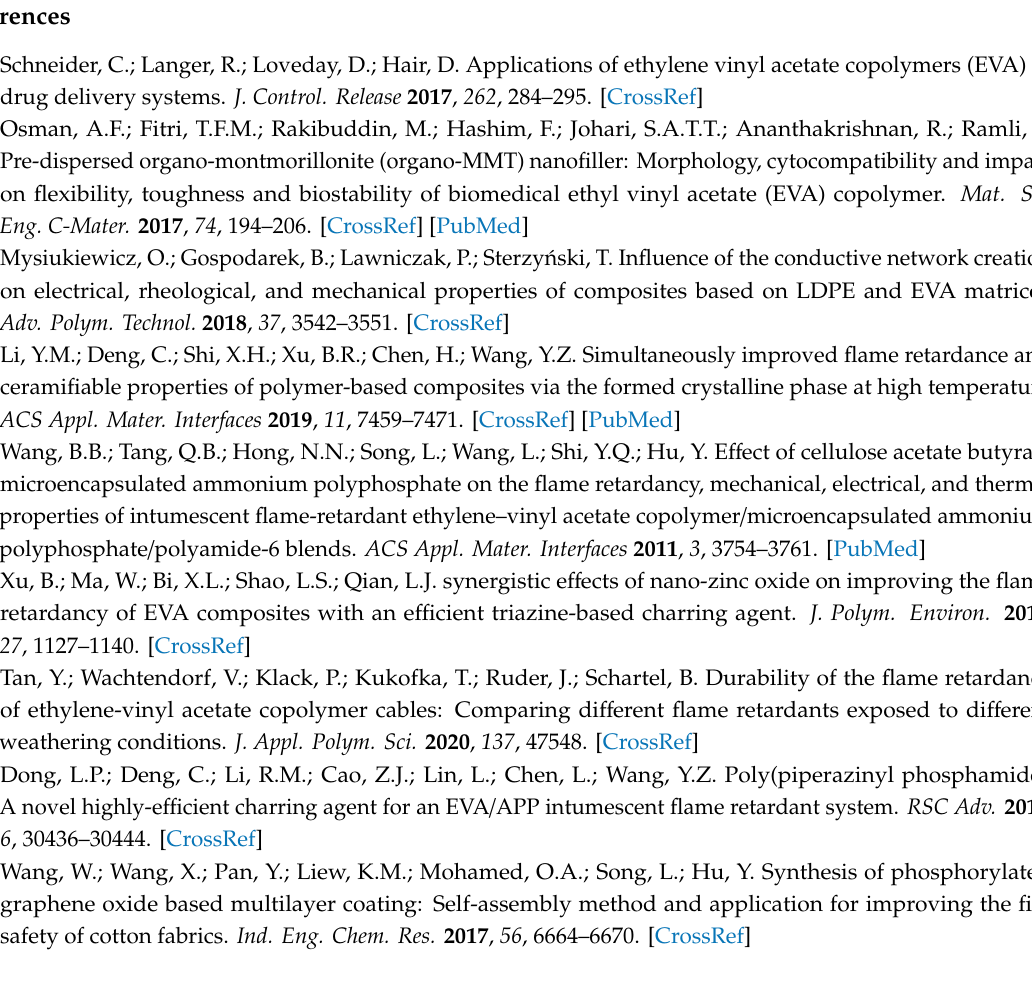
Figure S1: Illustration of the interface assembly procedure of APP-ZIFs, Figure S2: Surface micromorphology of EVA composites after hot water treatment tests (9 days), Figure S3: TG curves of EVA composites in nitrogen and air atmosphere, Figure S4: Elemental composition of the assembly frameworks in 25% APPZ4 / DPER surface char by EDS, Figure S5: TEM photo of 2D nano film structure (a), EDS mapping photos of the C, O, P, and Co